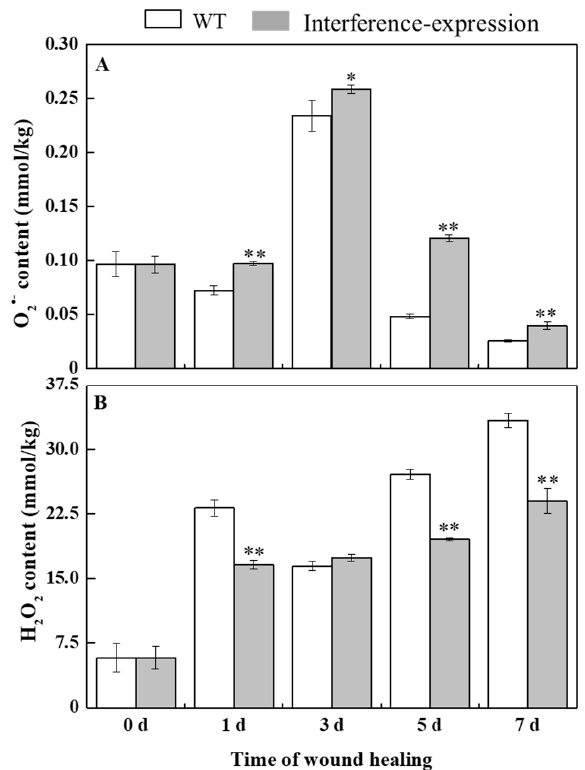
Figure 3. The interference expression of StMSD inhibited the disproportionation of O 2• − (A) to H 2 O 2 (B) in tubers during healing. Bars indicate standard deviation (± SD). Asterisks represent significant differences (* p < 0.05; ** p < 0.01). Each column represents the mean of three replicates. The healing was carried out at ambient temperature (20–25 °C; RH 80–90%) in the dark. The four RNAi lines were used in the experiment.